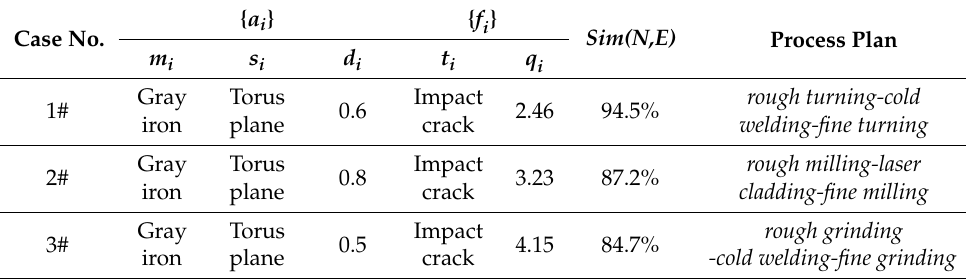
Table 3. The feasible process plans of surface A 1.